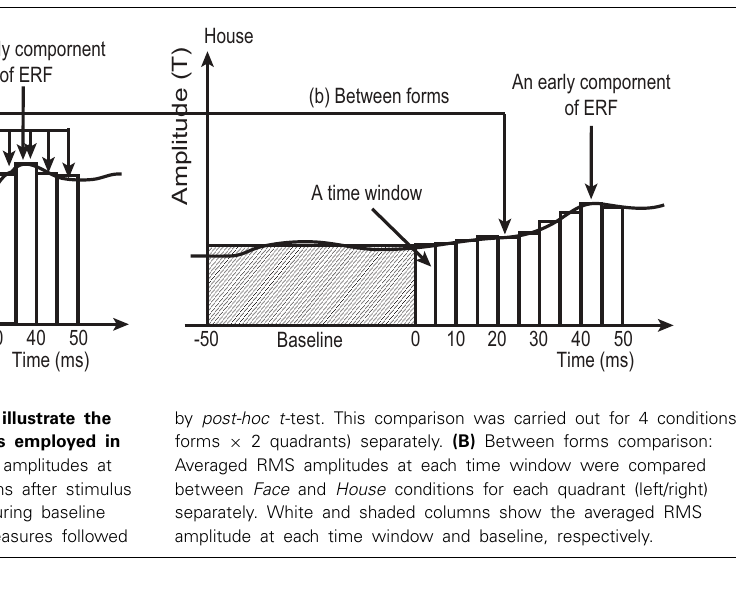
by post-hoc t -test. This comparison was carried out for 4 conditions (2 forms × 2 quadrants) separately. (B) Between forms comparison: Averaged RMS amplitudes at each time window were compared between Face and House conditions for each quadrant (left/right) separately. White and shaded columns show the averaged RMS amplitude at each time window and baseline, respectively.